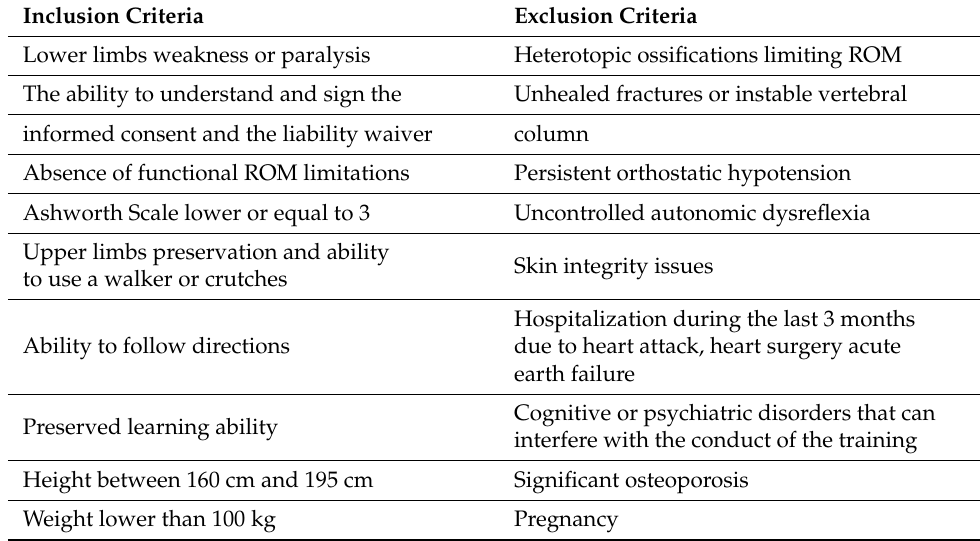
Table 1. Inclusion criteria for training with UAN.GO ®